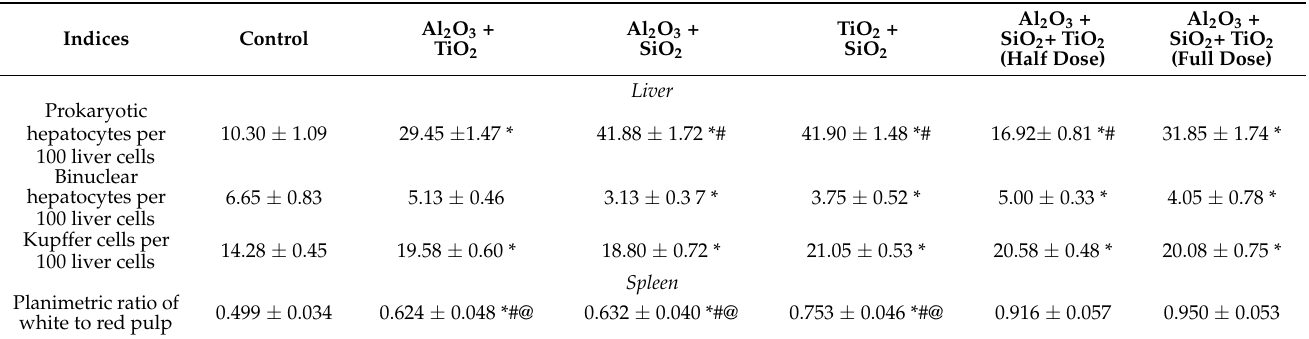
Table 3. Morphometric indices of rat liver and spleen following subchronic exposure to binary and ternary mixtures of Al 2 O 3 , TiO 2 and SiO 2 (X ±